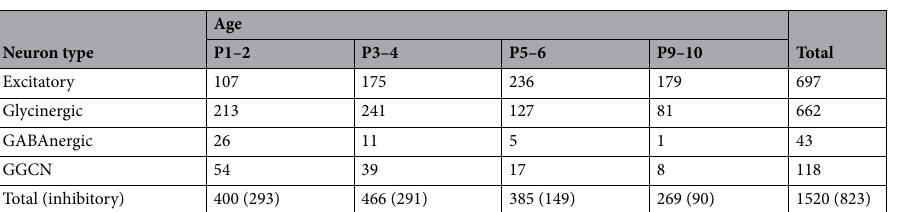
decreased from p1–2 (14%; 12–18%; n = 5) to the latter two groups, p5–6 (4%; 0–6%; n = 5) and p9–10 (3%; 0–8%; n = 5) (Fig. 2A). GABAergic inspiratory neurons formed the smallest population among the four types of inspiratory neurons from p1 to p10. The percentage of GABAergic inspiratory neurons among total inspiratory neurons at p1–2 (7%; 2–13%; n = 5) further decreased even at p3–4 (2%; 0–3%; n = 5) (Fig. 2A). Then, we con- ducted Pearson’s chi-square test using the total number of inspiratory neurons in each group divided by age and neuron type from five rhythmic slices (Table 1). The compositions of the population of inspiratory neurons were significantly different among age groups ( P < 0.0001). These results indicate that putative excitatory inspiratory neurons driving rhythmic bursts would become the principal population in the inspiratory neuronal network in the preBötC at p5-6, although glycinergic inspiratory neurons are the major population at birth. Consequently,